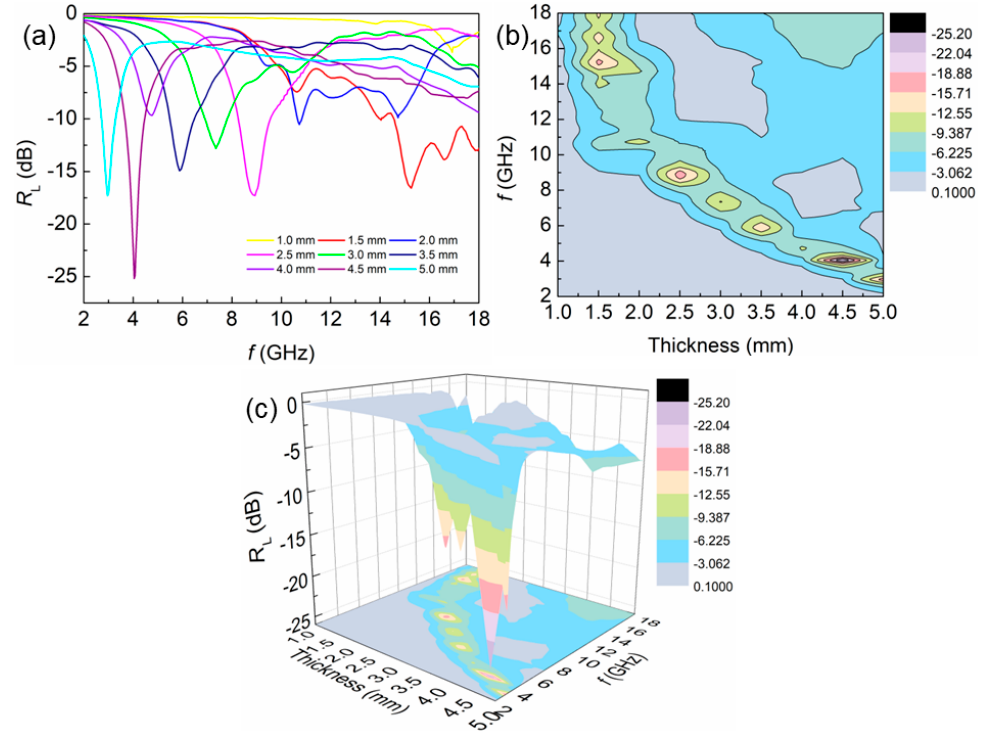
Figure 2. Frequency dependence of reflection loss and sample thickness of as-prepared FeSiBNi2 metallic microwires when the mass ratio is 30 wt.% with the thickness of the composite ranging from 2–18 GHz: ( a ) frequency dependence of R L curves; ( b ) 2D contour plots of thickness and reflection loss; ( c ) 3D variation diagram of reflection loss after fitting.